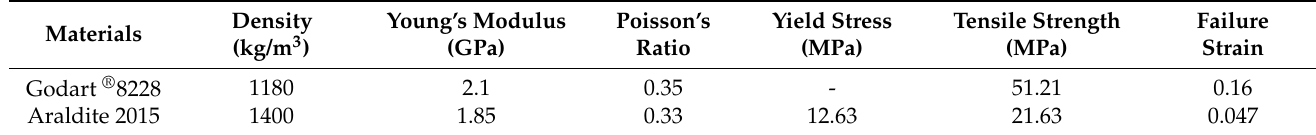
Table 2. Material parameters of core and adhesive [19].